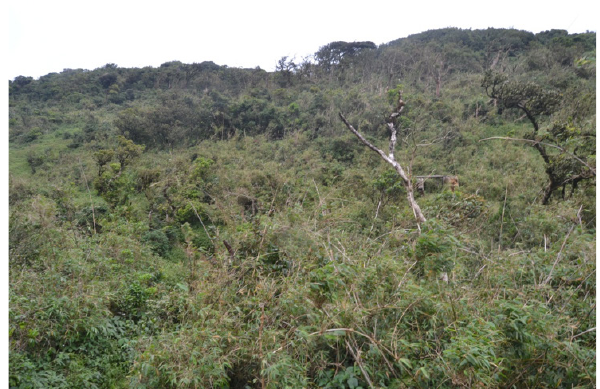
Figure 6: A spread of Davidsea attenuate , a native bamboo species, in lower montane forests in the Knuckles Conservation Area in Sri Lanka. High prevalence of forest die-back patches is also reported in these forests, prompting speculation that there is a connection between bamboo over-abundance and forest die-back. © Tharanga